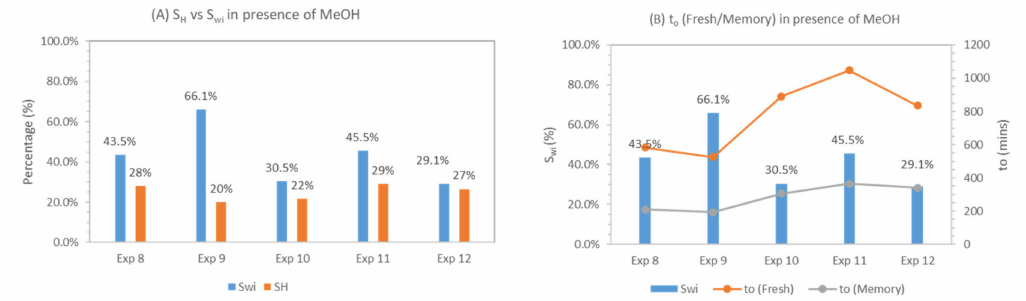
Figure 8. Hydrate saturation and induction time (fresh and memory) for experiments 8–12. ( A ) Variation in S H and S wi during experiments 8–12; ( B ) Variation in induction time (t o ) (Fresh / memory) during experiments